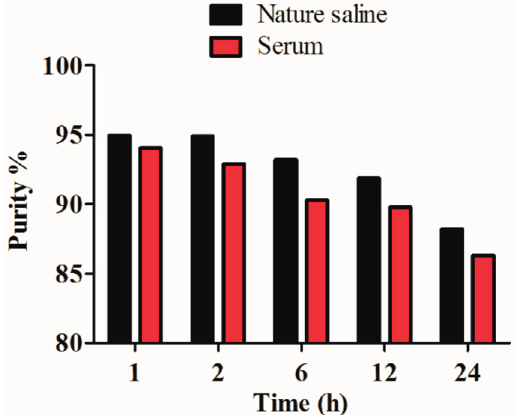
Figure 3. In vitro stability. Radiochemical purity of the 99m Tc-RGD4C β L remained more than 88% and 86% periodically over 24 h in normal saline at room temperature (25 °C) and